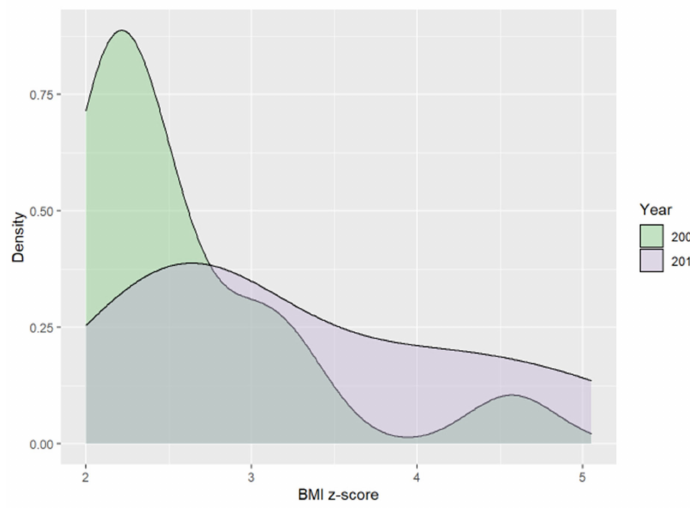
Figure 2. Ten-year differences in BMI z-scores in obese